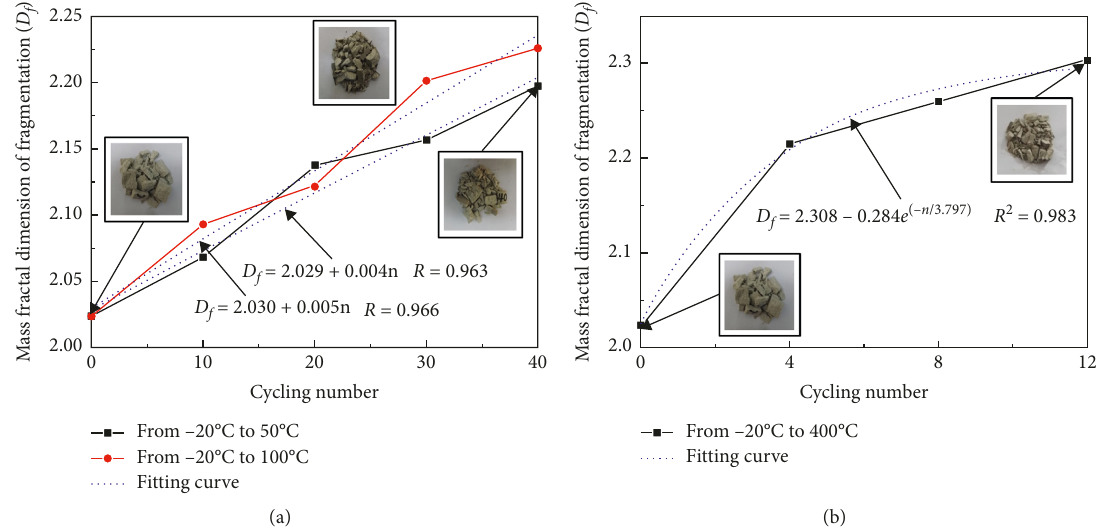
Figure 14: Relation of mass fractal dimension of fragmentation with cycling number. (a) L-T group and M-T group and (b) H-T